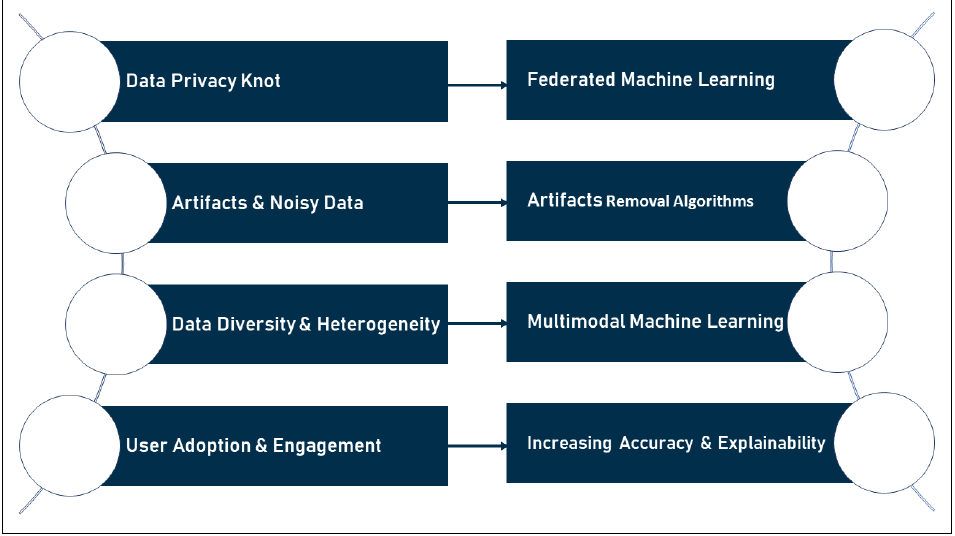
Figure 12. Challenges–future solutions